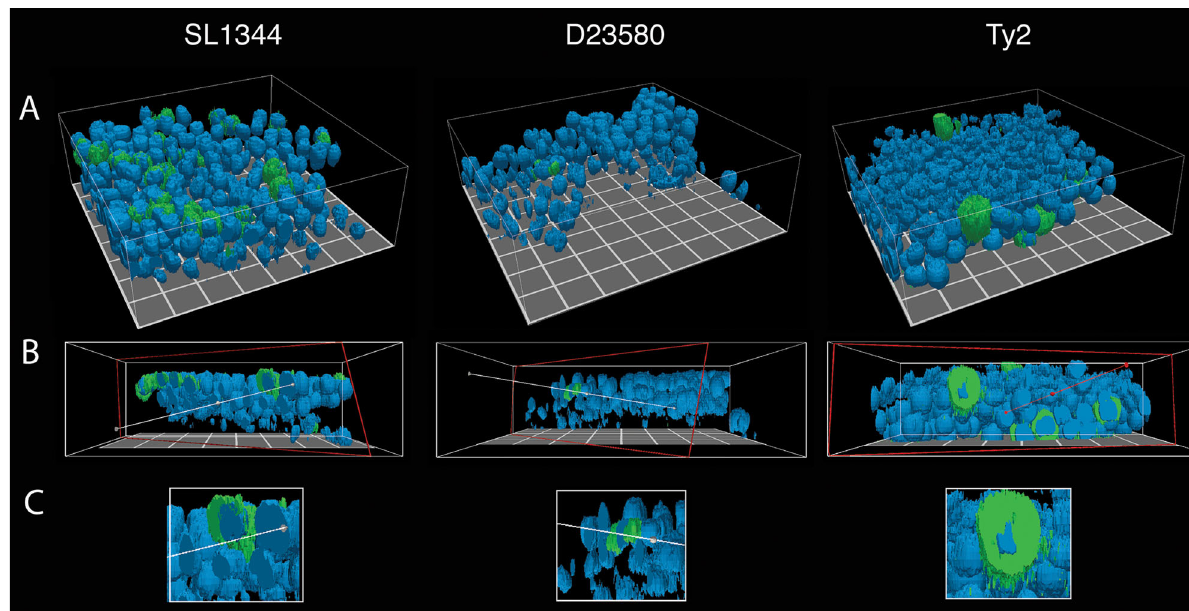
Fig. 7 3-D perspective of intracellular Salmonella in epithelial cells. The co-culture model was fi xed 24 h.p.i. with SL1344, D23580, or Ty2 grown microaerobically, stained with anti- Salmonella antibody ( green ) and DAPI ( blue , nuclei), and imaged with CLSM (Magni fi cation = 400×). Images were rendered as a 3-D perspective surface using an isovolume fi lter with ParaView (see Experimental Procedures). A Oblique view, B Axial view showing a cut-away slice, C digitally cropped image from ( B ) highlighting infected epithelial